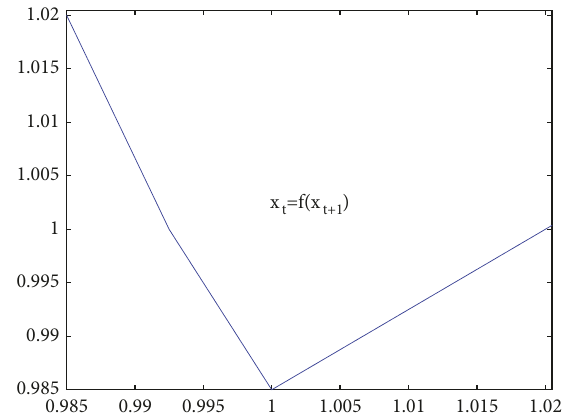
Figure 1: Backward map 𝑓 : [𝑥 𝑙 , 𝑥 ℎ ] 󳨀→ [𝑥 𝑙 , 𝑥 ℎ ] from the cash-in- advance model. It is reproduced from Kennedy et al. [4] [under the Creative Commons Attribution License/public